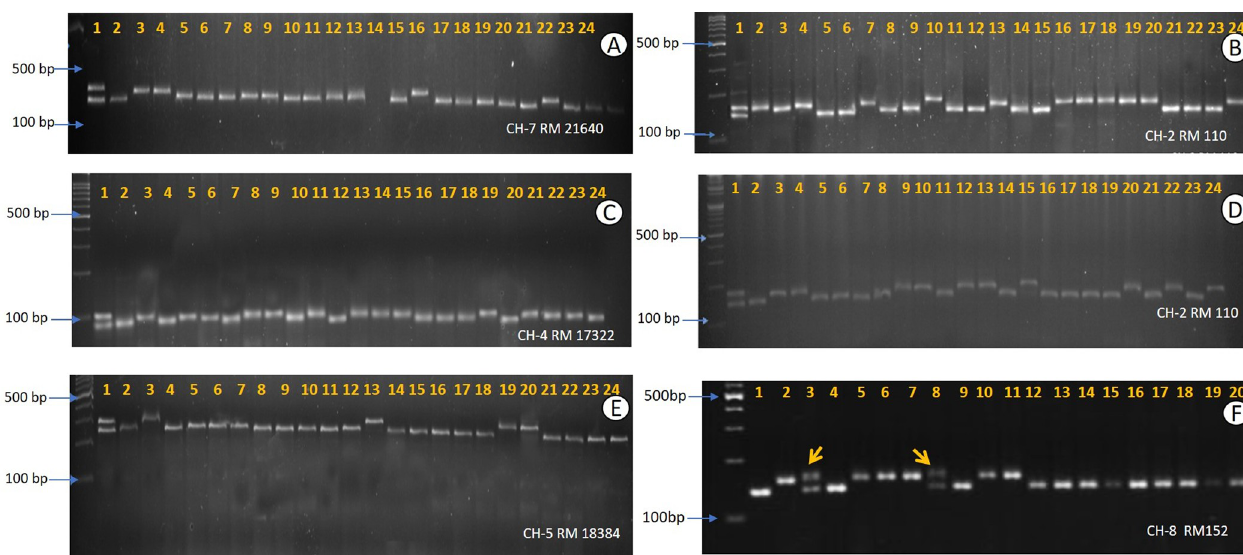
Fig 3. Discrimination of doubled haploid and heterozygous diploids using SSR markers. A) 1: Arize 8433DT; 2–24: Derivative DHs B) 1: Arize 6453; 2–24: Derivative DHs C) 1: Arize Bold; 2–24: Derivative DHs D) 1: Swift Gold; 2–24: Derivative DHs E) 1: F 1 s of Savitri x Pokkali; 2–24: Derivative DHs F) 1: IR20 2: Mahulata; 4–7 & 9–20: Derivative DHs; 3 & 8: Heterozygous diploids